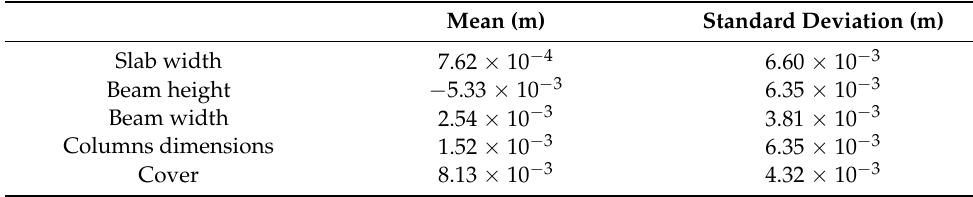
Table 4. Statistical parameters for structural